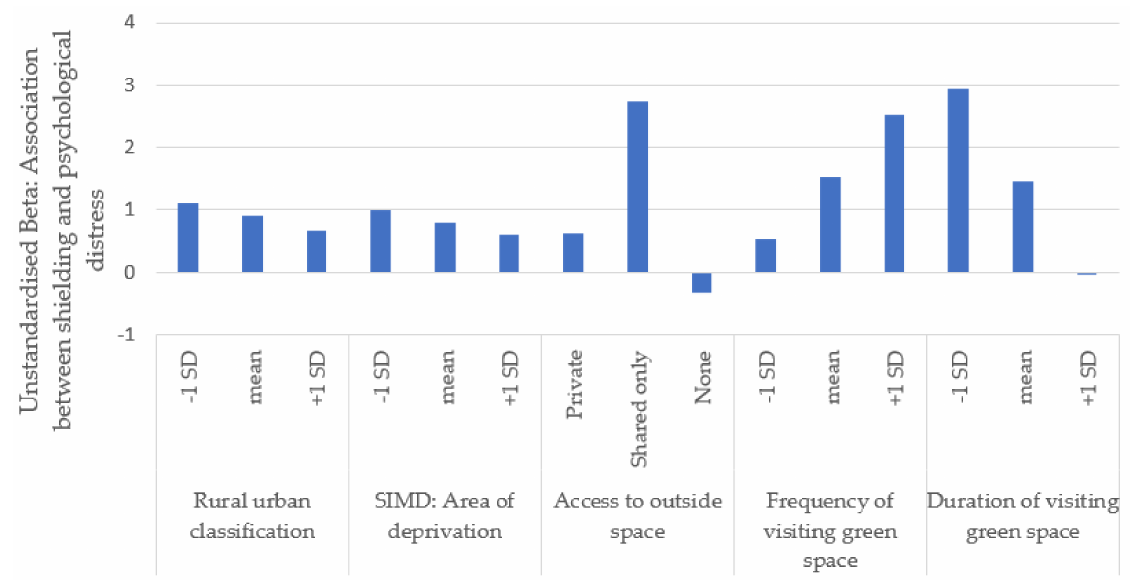
Figure 1. Effects of moderations between shielding category and the environment (Study 1 and Study 2) on psychologi- cal